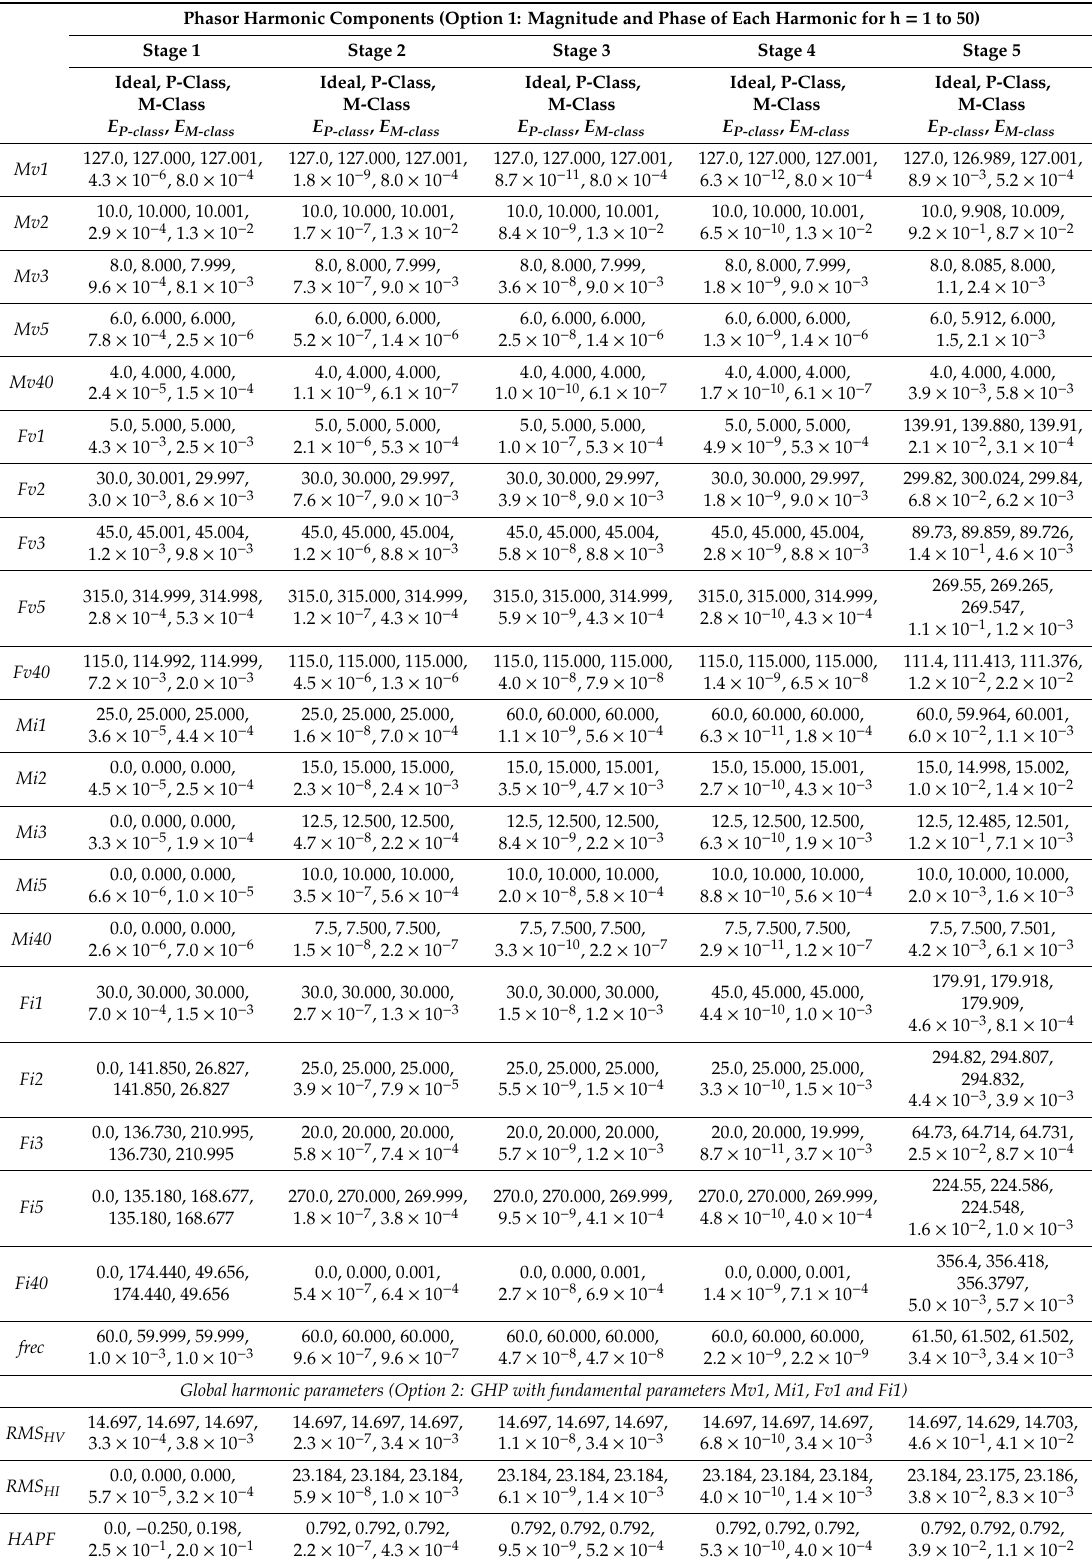
Table A1. Numerical results of harmonic phasor measurement unit (HPMU) for synthetic signals. Phasor Harmonic Components (Option 1: Magnitude and Phase of Each Harmonic for h = 1 to